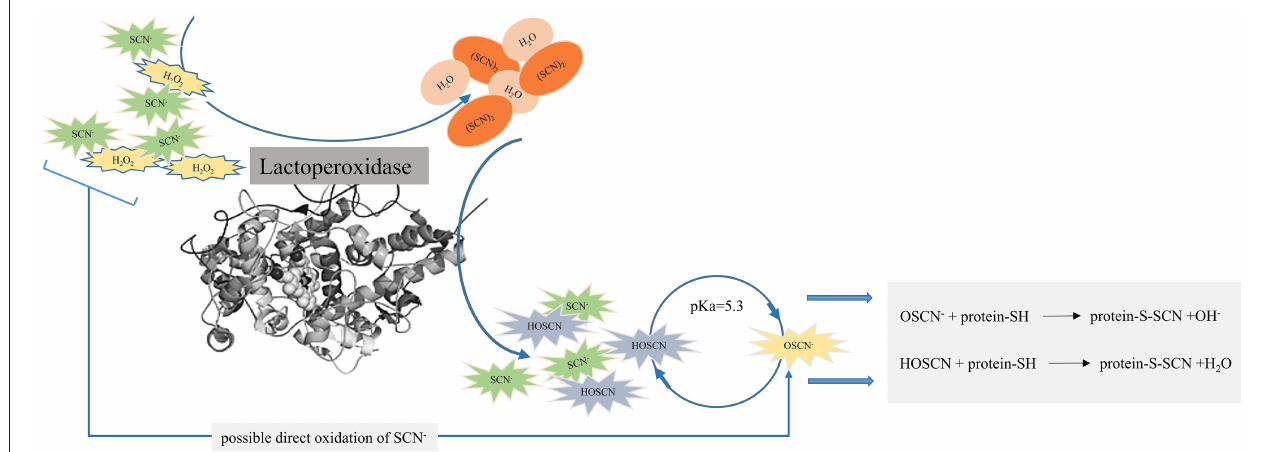
FIGURE 2 | Antimicrobial activity of lactoperoxidase enzyme (LPO) by the oxidation of sulfhydryl (SH) groups of microbial enzymes and other proteins with hypothiocyanous acid (HOSCN) and hypothiocyanite (OSCN −